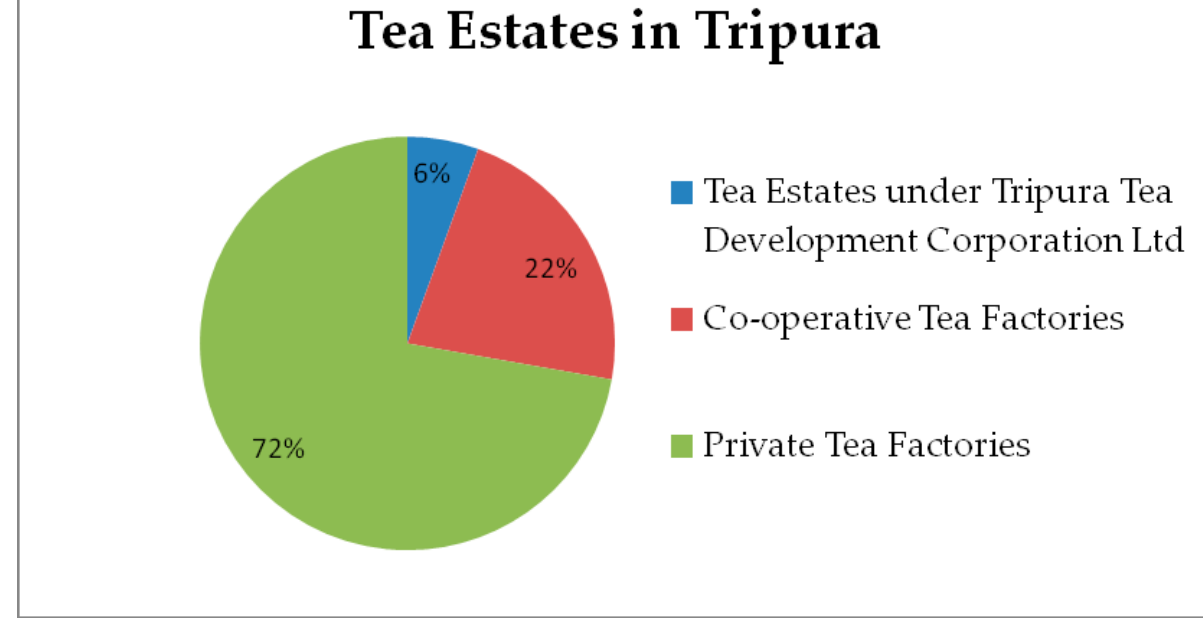
Figure 2. Pie chart showing the position of Tea Estates in Tripura.